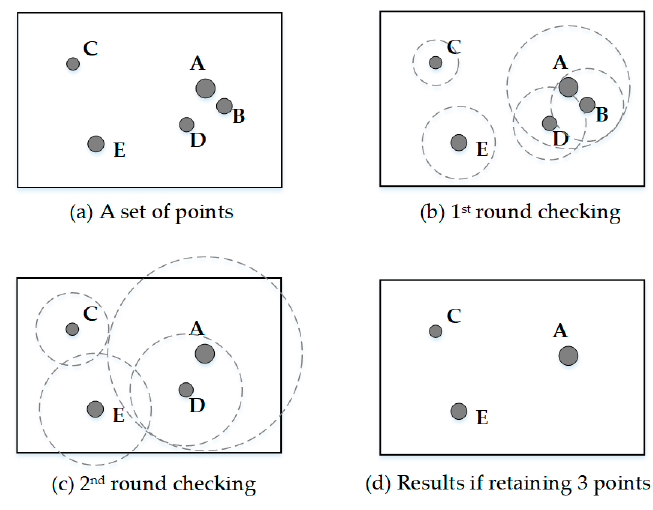
Figure 6. Select procession of points by circle growth algorithm, Source: [7] (p. 83).